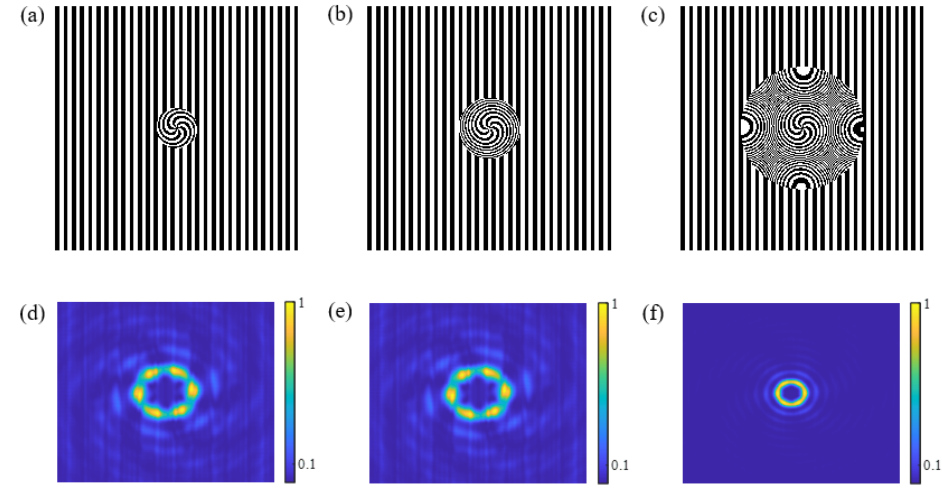
Figure 10. Schematic diagrams of the CSZPG with the parameter of ( a ) R = 1000 μ m, ( b ) R = 1500 μ m and ( c ) R = 3000 μ m. ( d – f ) show the corresponding diffraction patterns for ( a – c ).